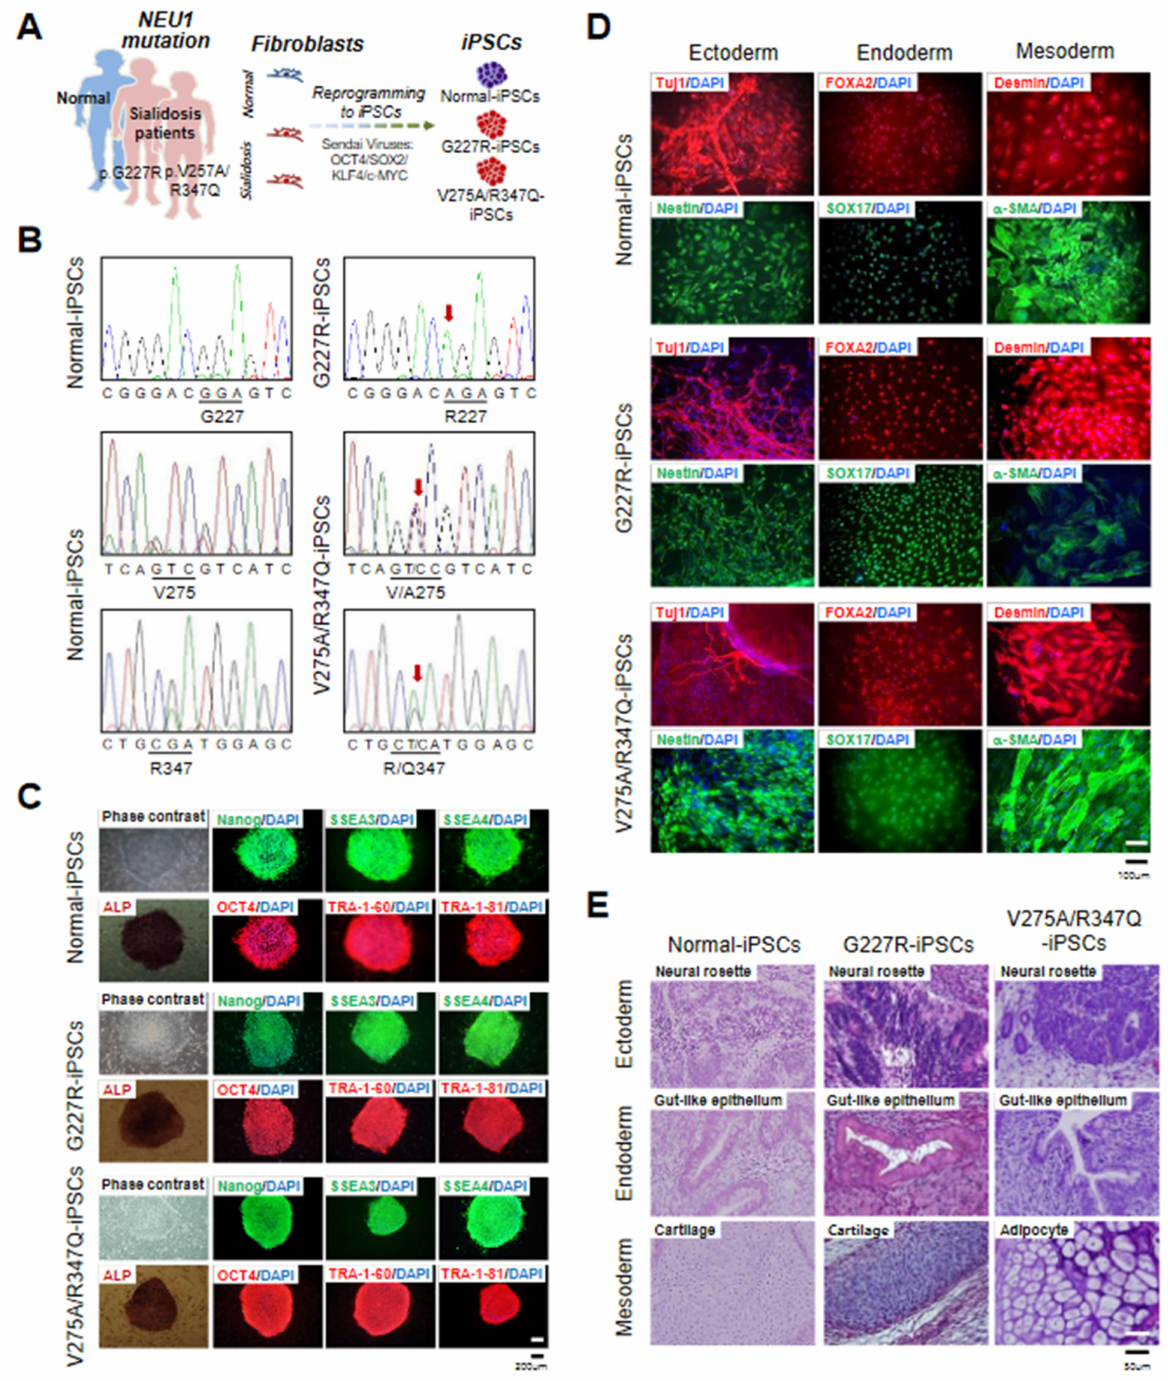
Figure 1. Derivation and characterization of normal and sialidosis-iPSCs. ( A ) Schematic representation of iPSC derivation from fibroblasts. ( B ) DNA sequences of the NEU1 gene in normal- and sialidosis-iPSCs (G227R- and V275A/R347Q-iPSCs) derived from normal or sialidosis patient fibroblasts carrying the G227R or V275A/R347Q mutations in NEU1 . ( C ) Representative phase contrast images of iPSCs with or without alkaline phosphatase (ALP) staining and immunohistochemistry images of iPSCs stained for the pluripotency markers NANOG, SSEA3, SSEA4, OCT4, TRA1-60, and TRA-1-81. (Scale bar = 200 µ m) ( D ) Representative immunohistochemistry images of differentiated iPSCs stained for ectoderm (TUJ1 and NESTIN), endo- derm (FOXA2 and SOX17), and mesoderm (DESMIN and α -SMA) markers. Nuclei were counterstained with DAPI (blue). (Scale bar = 100 µ m) ( E ) Representative images of hematoxylin and eosin (H&E)-stained teratoma sections showing the three germ layers: ectoderm (top panel), endoderm (middle panel), and mesoderm (bottom panel). (Scale bar = 50 µ